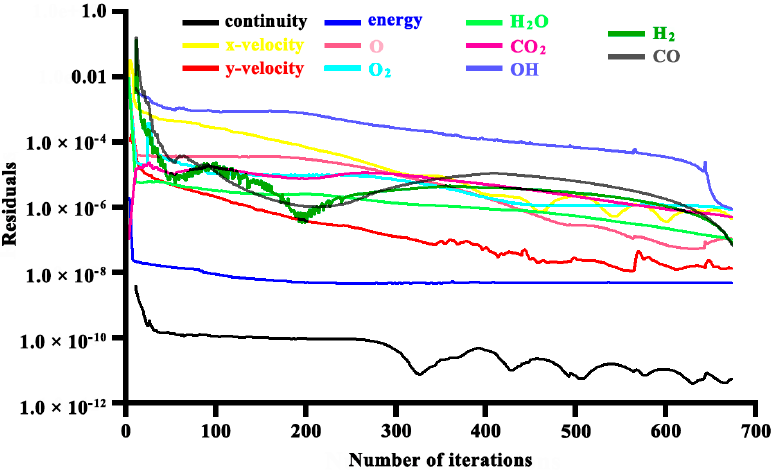
Figure 4. Values of the residuals of the conservation equations after each iteration. The mesh consists of 100 axial nodes by 200 transverse nodes. The rest of the parameters used are the same as those shown in Figure 3.